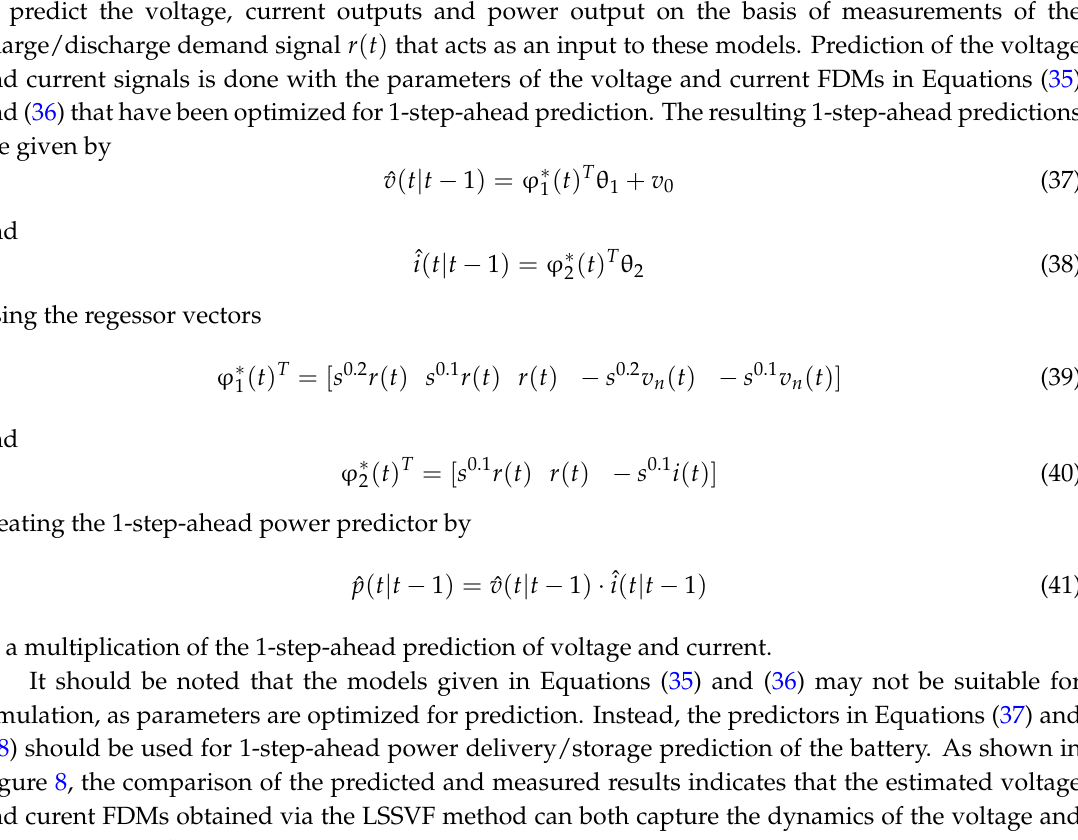
( t , θ ) and current model ε 2 1 fv